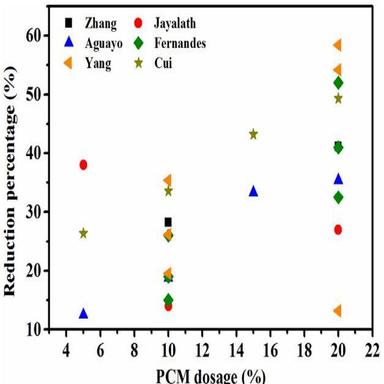
The reduction percentage of compressive strength in literatures .